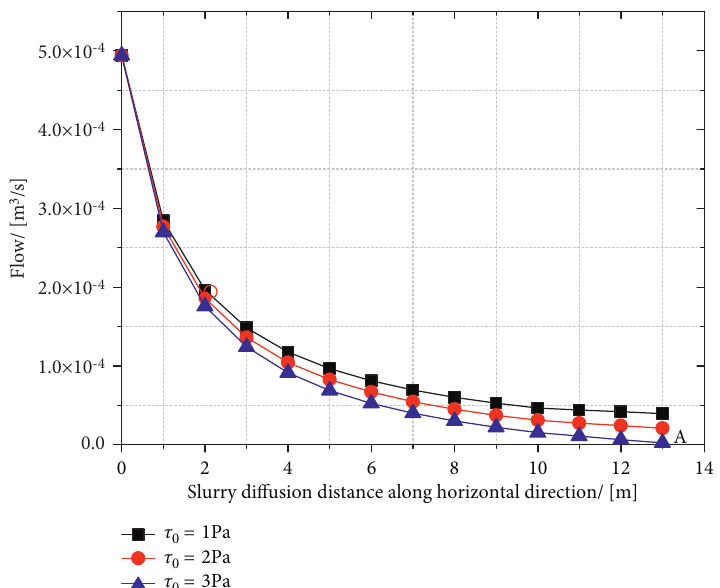
Figure 5: Relationship between system flow rate and slurry displacement diffusion distance (different yield stress